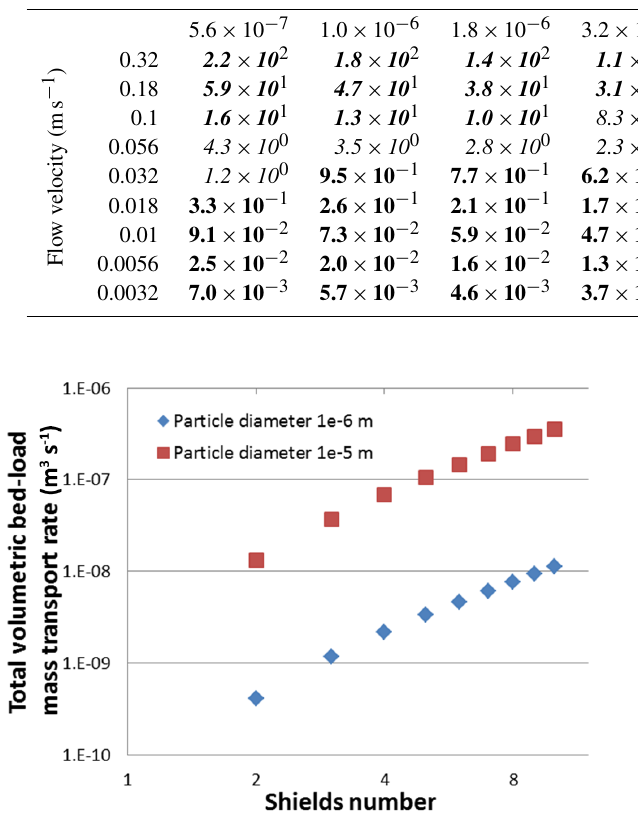
Figure 4. Bed-load transport rate per unit width (in the cross- sectional direction of a channel) as a function of the Shields number and for particle diameters as indicated. See the text for parameter values assumed in this